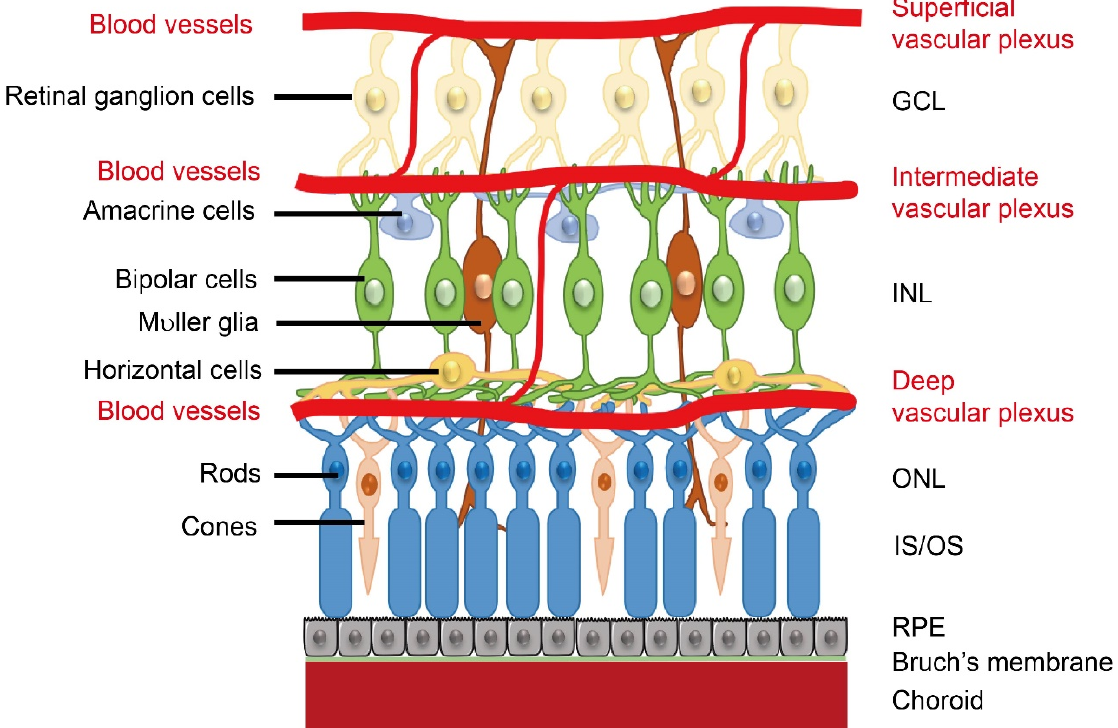
Figure 1. Schematics of retinal neuronal and vascular structure. There are three layers of retinal vascular plexuses tightly coordinated with retinal neurons. GCL, ganglion cell layer; INL, inner nuclear layer; ONL, outer nuclear layer; OS / IS, outer segments / inner segments; RPE, retinal pigment epithelium. Schematics were drawn by Dr. Shuo Huang, Ophthalmology, BCH.